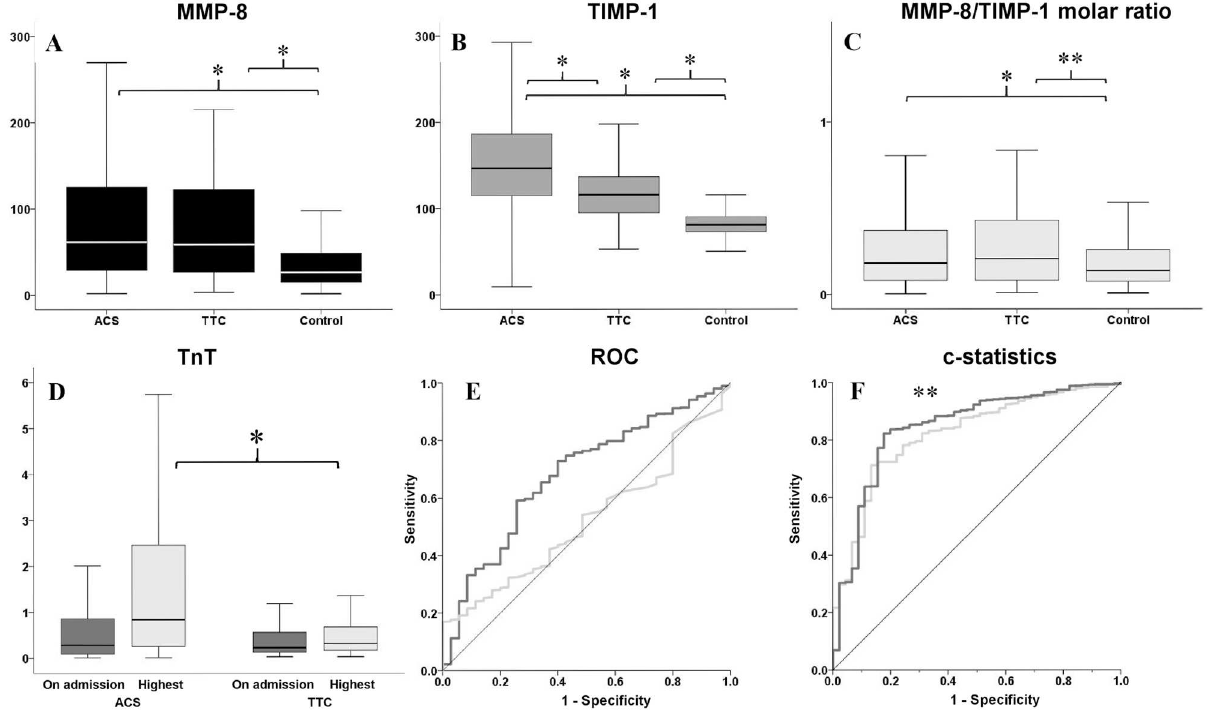
Fig 1. Differencesin acute-phase levels of A) matrix metalloproteinase-8(MMP-8), B) tissue inhibitorof matrix metalloproteinase-1(TIMP- 1), and C) MMP-8/TIMP-1 molar ratio of acute coronary syndrome(ACS) (n = 2072) and takotsubo cardiomyopathy (TTC) (n = 45) comparedto those of controls. D) TroponinT on admissionand highestvalue duringhospitalization in ACS and TTC. E) ROC curves of TIMP-1 and troponin T in differentiationof ACS from TTC. F) ROC curves after c-statistics showingthe improved ability of TIMP-1 + other differing factors (age, sex and smoking) in differentiationbetweenTTC and ACS over other differing factors alone (Table 2). Data in box- plots are presented as medians,25th and 75th percentiles(boxes), and 10th and 90th percentiles(whiskers). * p < 0.001; ** p =